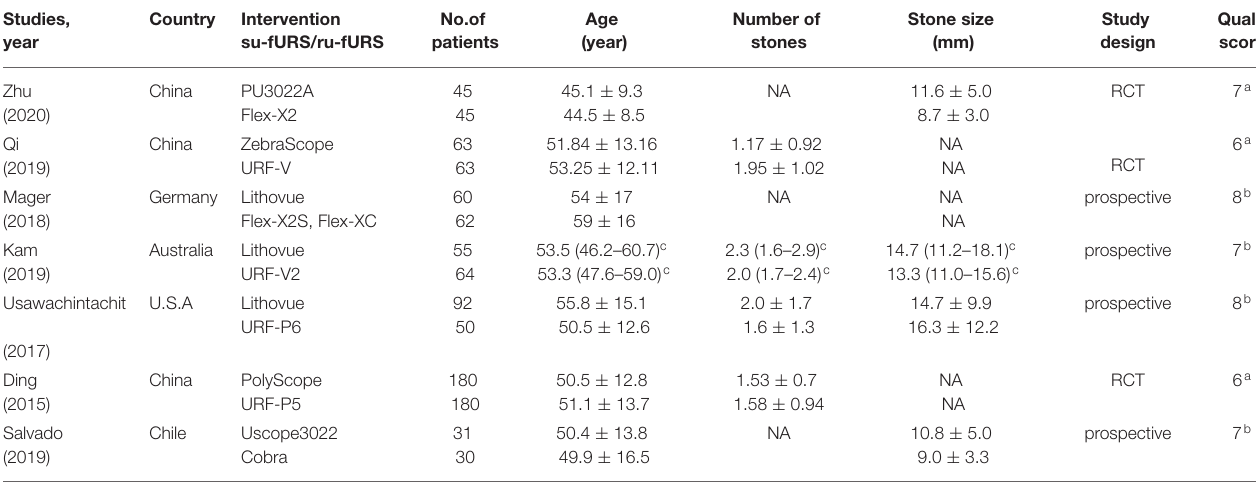
TABLE 1 | Baseline characteristic of included studies. Studies,